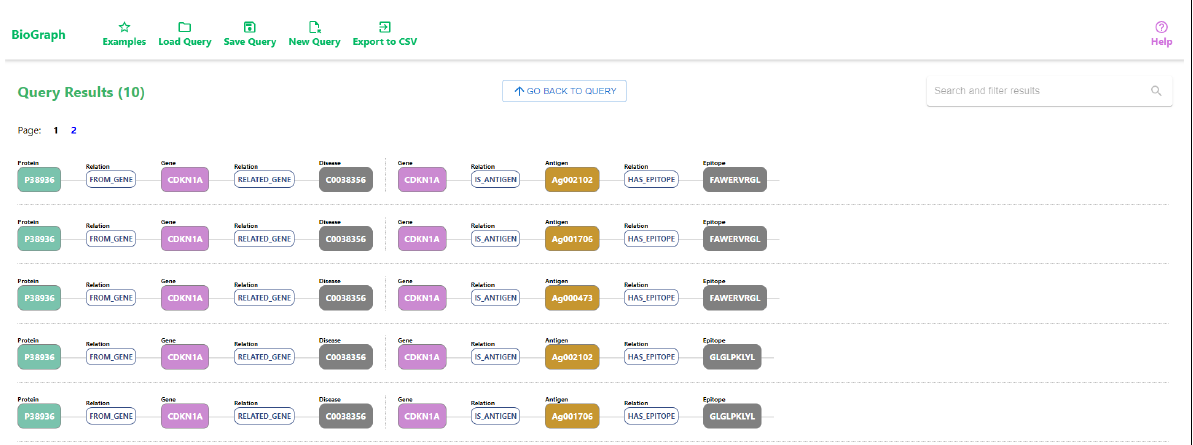
Figure 7. List of results received when querying the genes which are transcribed into highly disor- dered proteins (disorder content greater than or equal to 0.9) and linked with diseases with DisGeNET relation score of 0.5 and greater. We requested that the genes in the results are also tumor antigens and fetch all epitopes related to the antigens. The results are displayed as matched paths in the knowledge graph. The example shown in Figure 3 matches the first result in the list.